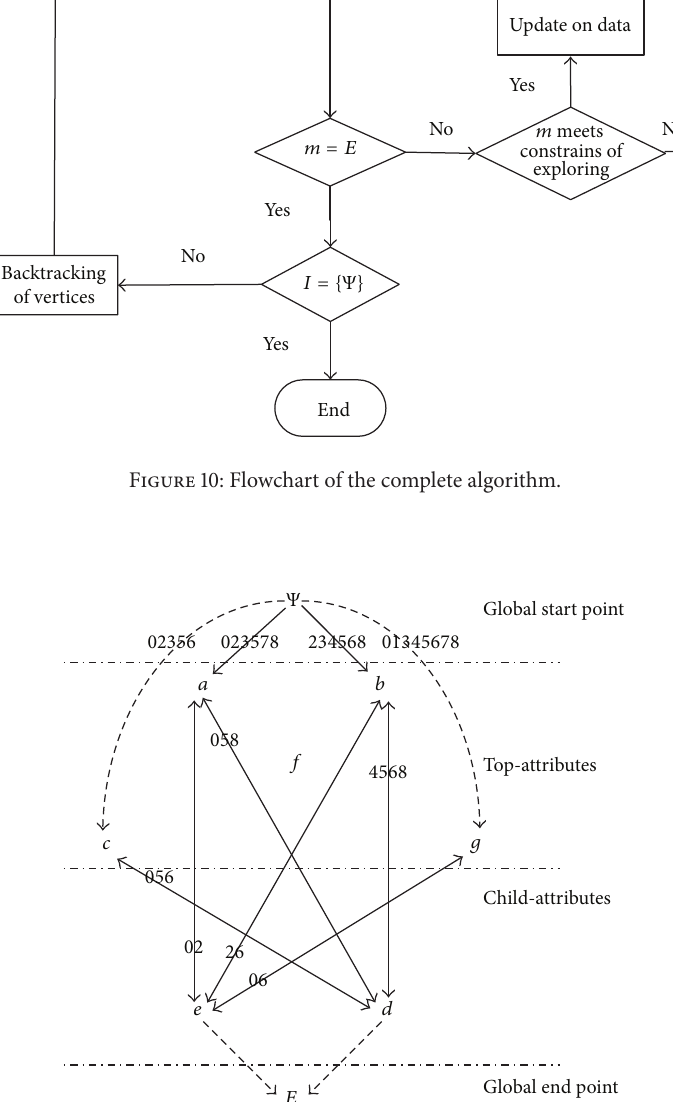
Figure 11: The updated attribute topology after the end of the